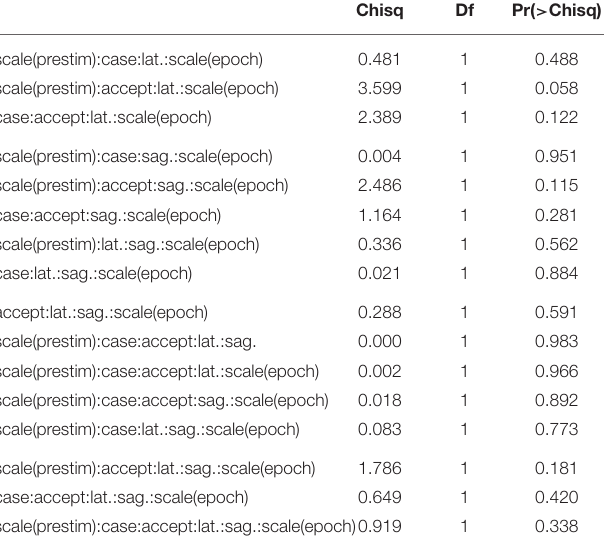
TABLE 5 | Summary of experiencer verb analysis including acceptability effects in late positivity time window (Type II Wald